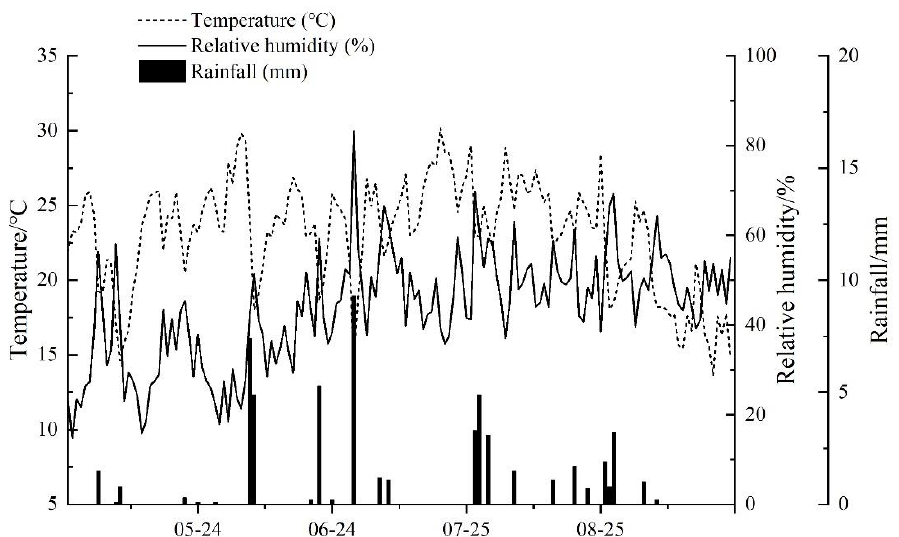
Figure 2. Meteorological data of the experimental site in company 10, 29th regiment, Korla, Xin- jiang, 2018.